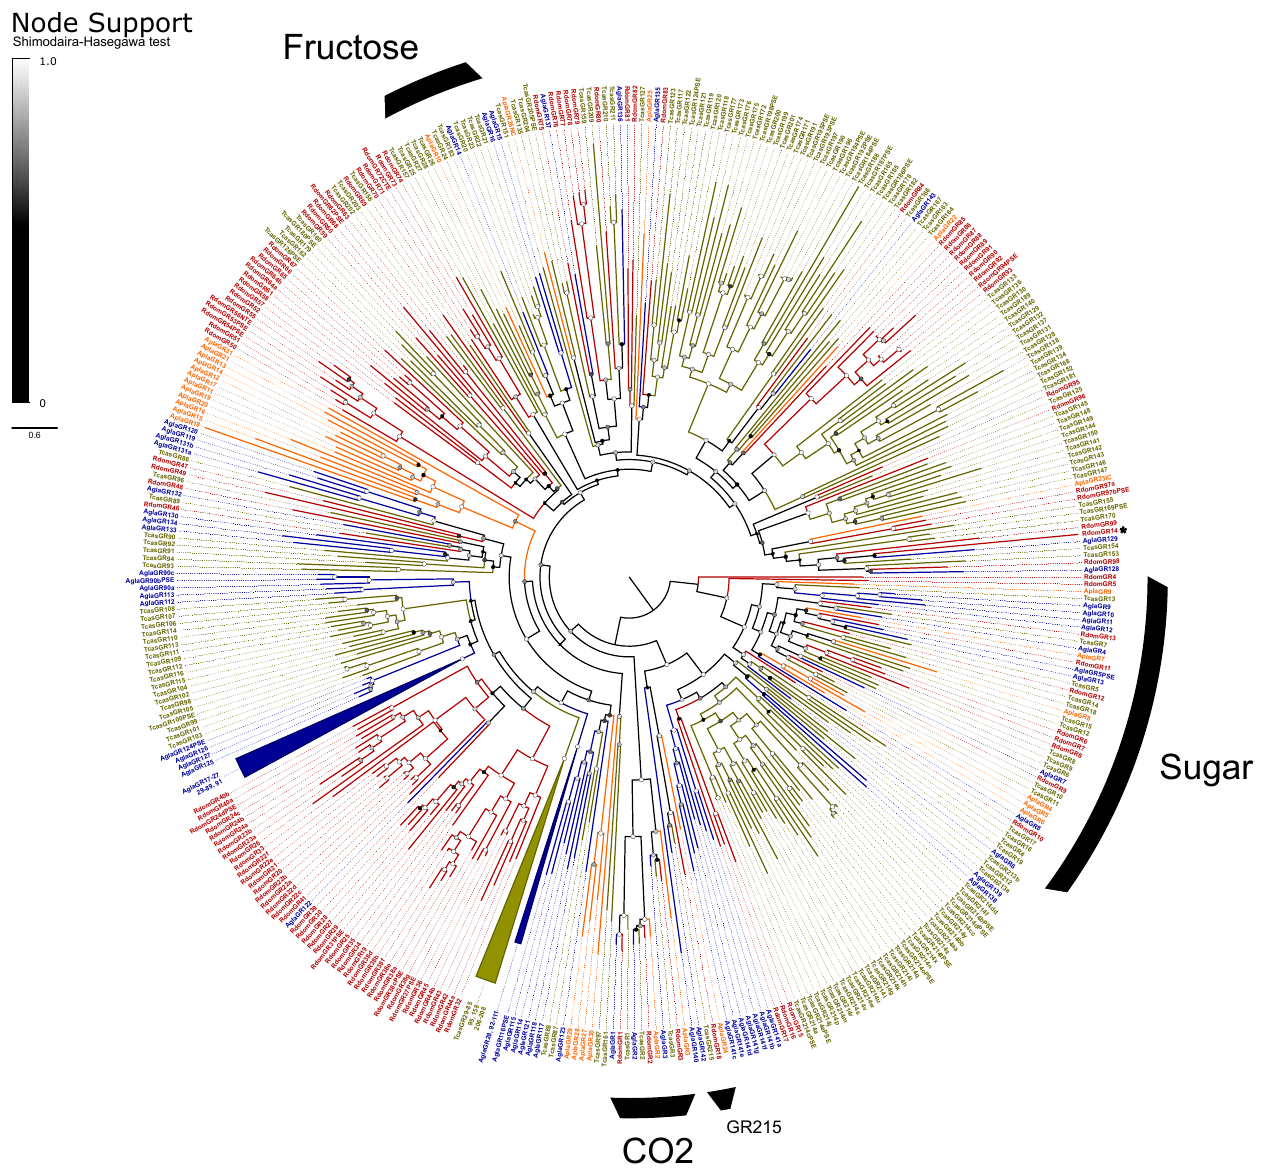
Figure 4. Phylogeny comparing gustatory receptors (GRs) of Rhyzopertha dominica (red) to those of Anoplophora glabripennis (blue), Tribolium castaneum (yellow), and Agrilus planipennis (orange), rooted with the conserved lineage of sugar-sensitive receptors. Colored circles at nodes represent Shimodaira–Hasegawa support values, shaded from black (0–0.5) to white (1.0). Black arcs describe the known monophyletic subfamilies of coleopteran GRs, and remaining unlabeled GRs are assumed to be bitter sensitive. Three large lineage ‐ specific radiations of GRs have been collapsed for clarity; identities of the removed genes are listed next to the collapsed sector. An asterisk denotes RdomGR14, which is likely to be a divergent member of the fructose GRs (see text).